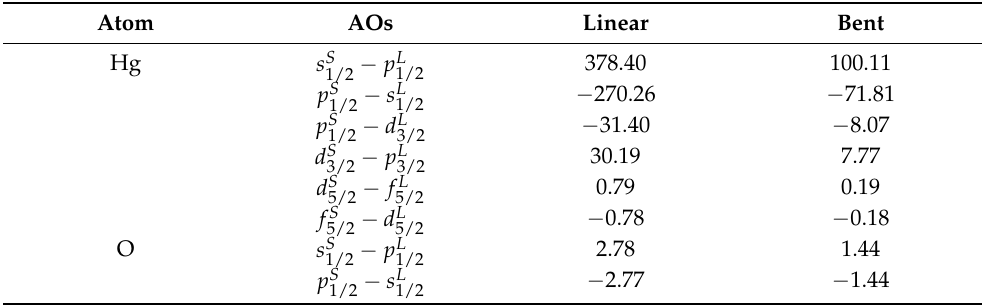
Table 4. Contributions from different atomic orbital (AO) mixing to the DHF value of E eff (in GV/cm), where the AO in the left hand side is a small component AO and that in the right hand side is a large component AO. Non-zero contributions may come only from odd-parity AO mixings (cid:104) ( AO ) S | ˆ O | ( AO ) L (cid:105) , where superscript S , and L stand for small component and large component AOs 1 2 respectively. Results are given for both the linear and the actual bent geometry HgOH molecule. Atom AOs Linear Bent